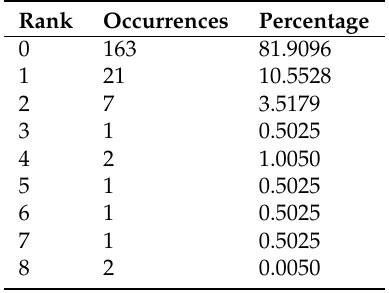
Table 2. Rank Assigned to the True Users